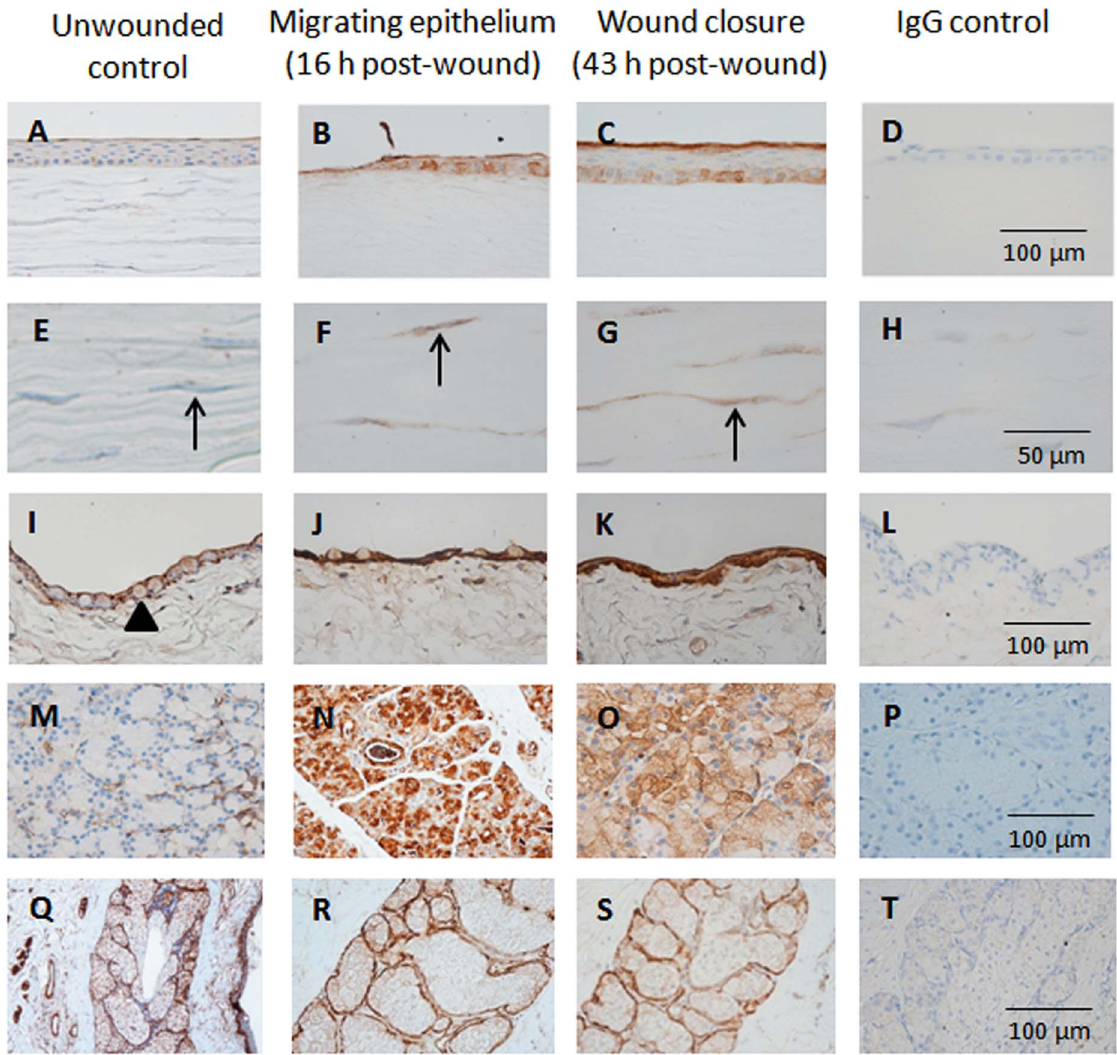
Figure 1. MMP-2 expression in ocular surface tissues. Representative light micrographs of tissue sections showing MMP-2 expression (A–D) corneal epithelium, (E–H) stromal keratocytes, (I–L) bulbar conjunctival epithelium, (M–P) lacrimal gland and (Q–T) meibomian gland of unwounded control eyes collected prior to surgery and wounded eyes at various phases of healing. Arrows indicate stromal keratocytes. Arrow head shows an example of a conjunctival goblet cell.